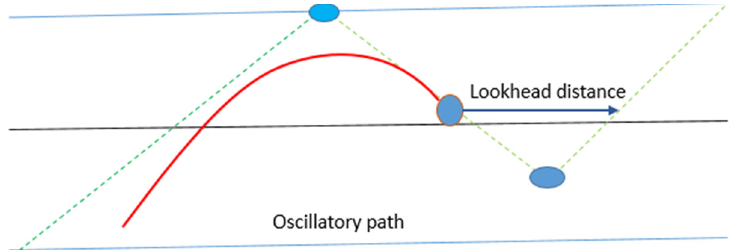
Figure 9. Larger look-ahead distance.